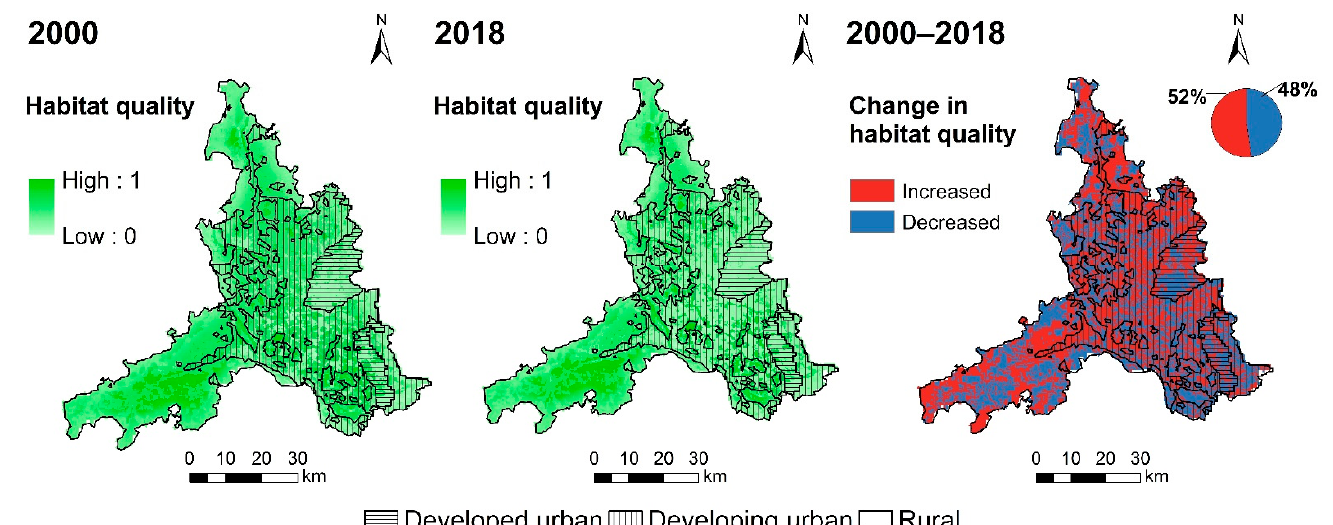
Figure 11. Spatial patterns of habitat quality in Foshan from 2000 to 2018.